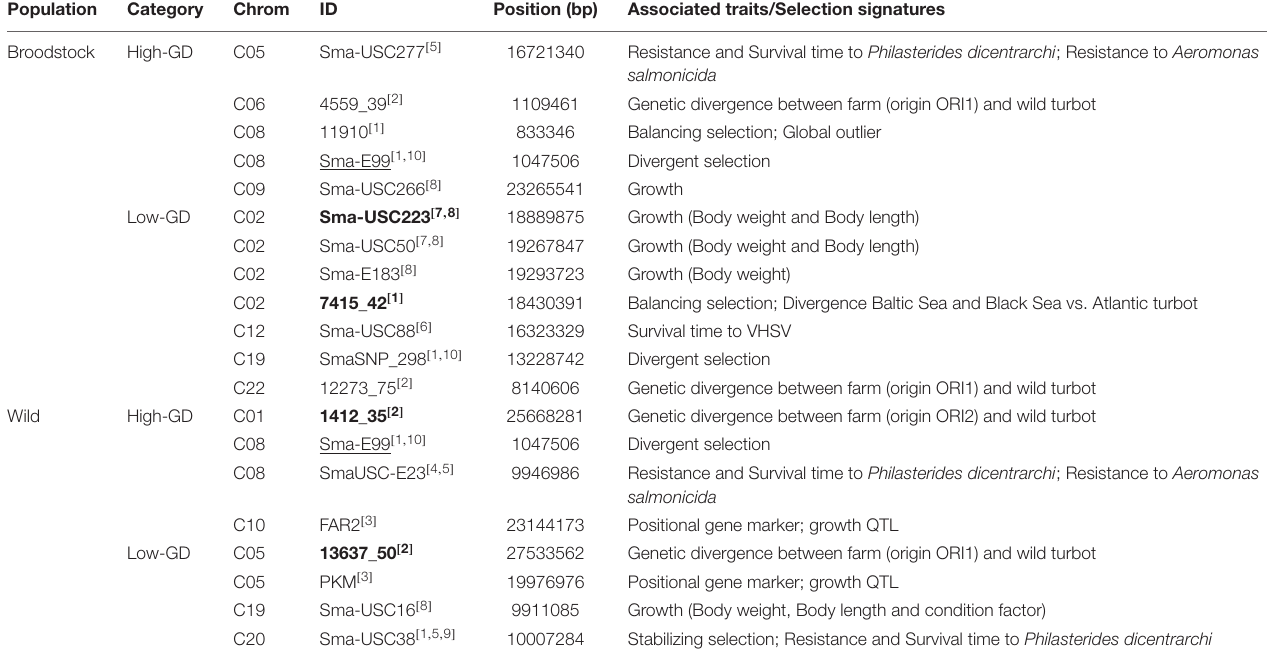
TABLE 2 | List of QTL-associated markers and outliers located in suggestive high-GD and low-GD regions for the broodstock and wild populations. Population Category Chrom ID Position (bp) Associated traits/Selection